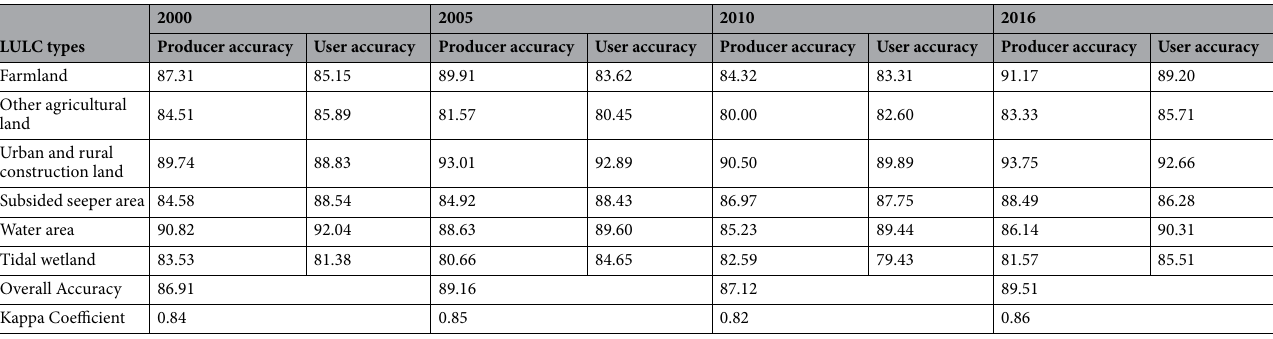
Table 1. Accuracy evaluation of the interpretation results